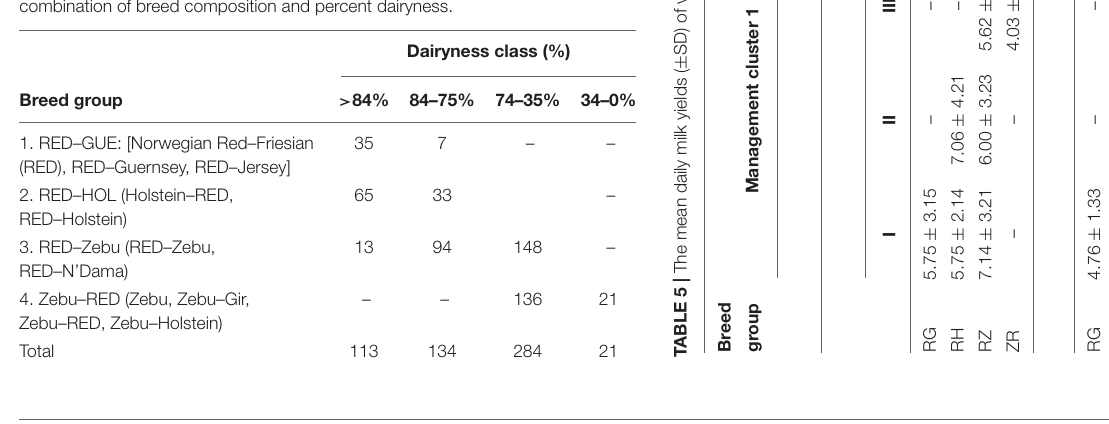
TABLE 4 | Number of cows included in the analysis, grouped based on a combination of breed composition and percent dairyness. Breed